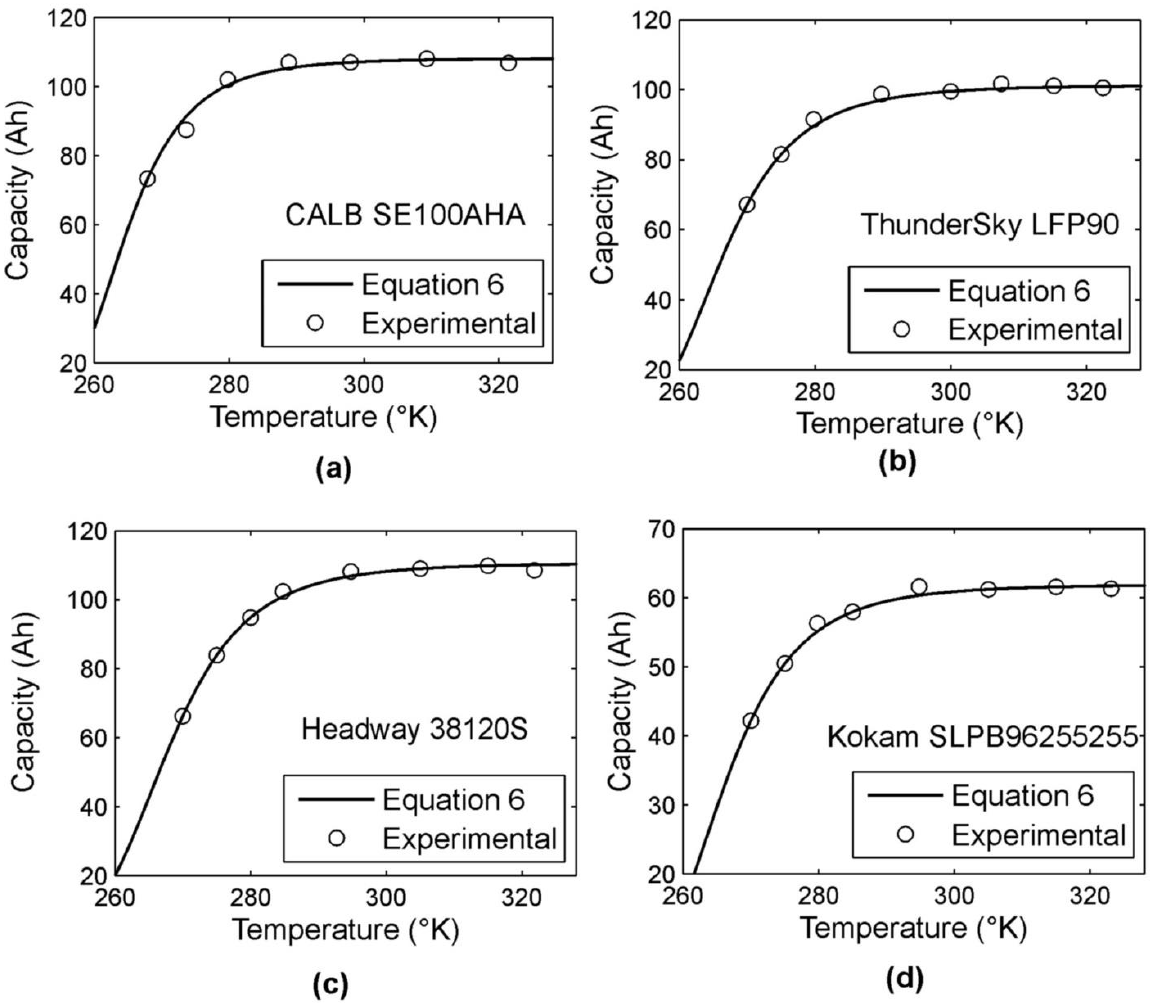
Figure 2. Comparison between Equation (6) and the experimental data for automotive-grade lithium-ion batteries: ( a ) batteries CALB SE100AHA; ( b ) batteries ThunderSky LFP90; ( c ) batteries Headway 38120S; ( d ) batteries Kokam SLPB96255255.